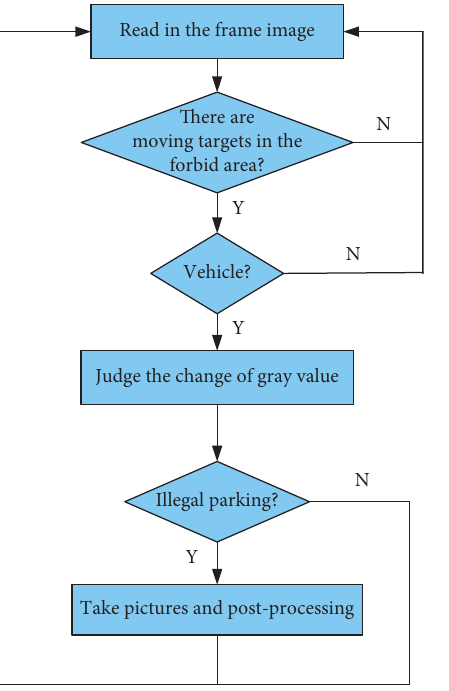
Figure 2: Flow chart of vehicle parking detection algorithm.